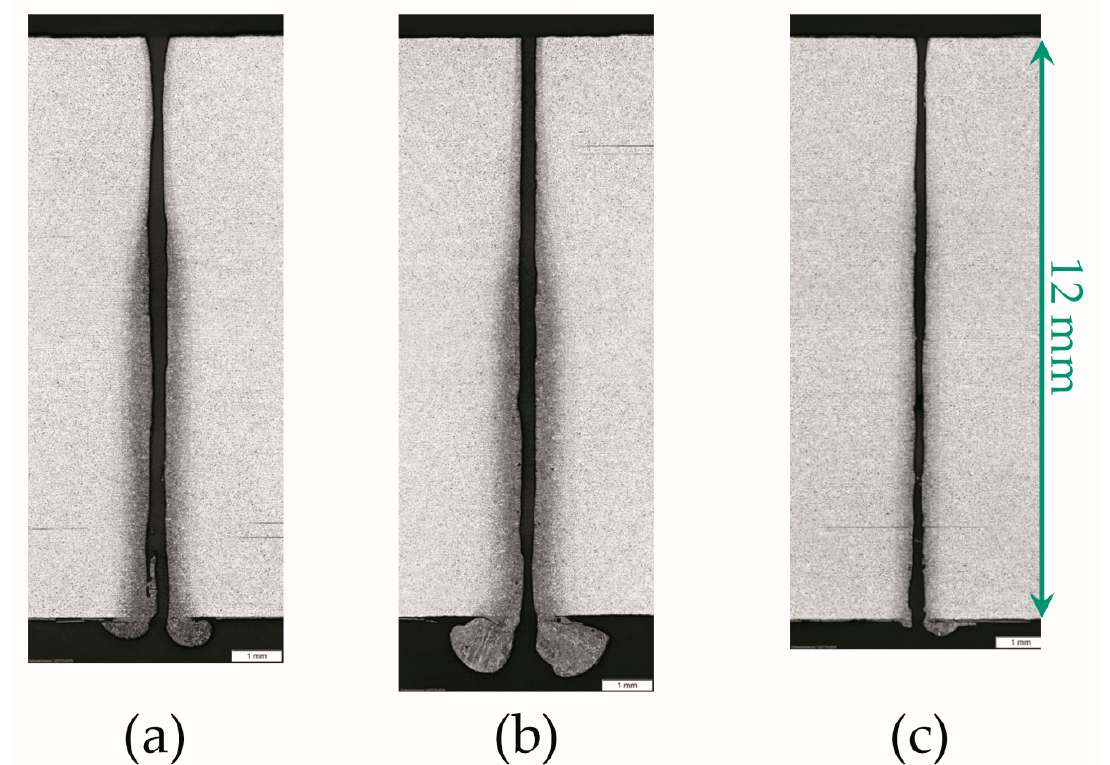
Figure 6. Microscopically images of polished and etched cross-sections of 12 mm laser beam fusion cut mild steel using different oscillation parameters: ( a ) 60 µm amplitude and 250 Hz frequency; ( b ) 60 µm amplitude and 4000 Hz frequency; ( c ) 500 µm amplitude and 250 Hz frequency.